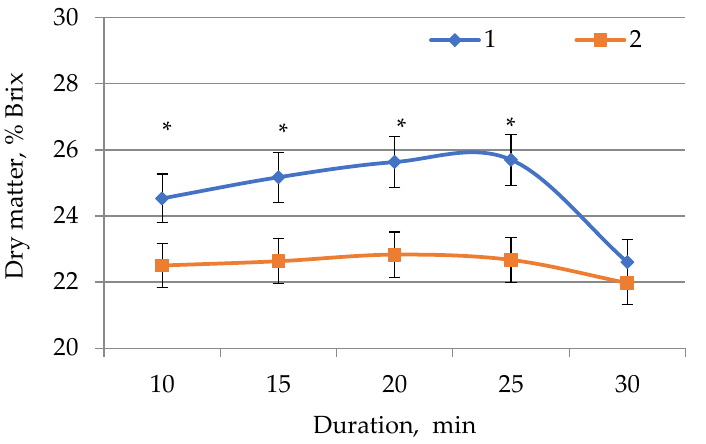
Figure 1. Dependence of the amount of dry matter in samples of E. globúlus extracts on the extraction time: 1—without US; 2—with US. Values followed by the symbol “*” do differ significantly ( p < 0.05) as assessed by post hoc test (Tukey test).